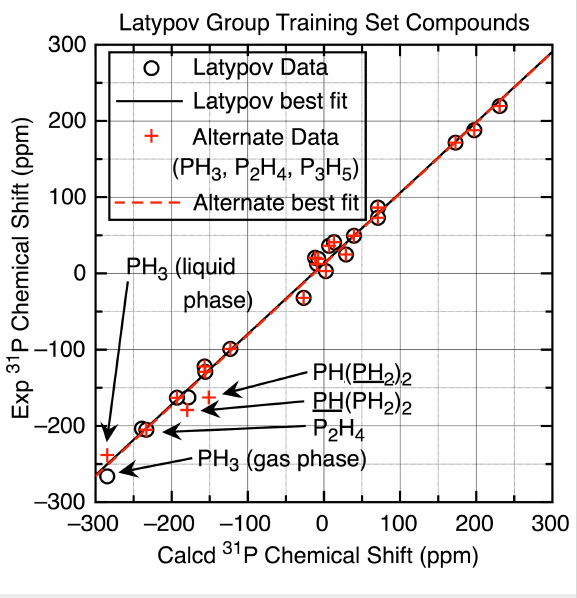
Figure 3: Plot of experimental vs calculated chemical shifts of training set compounds reported by Latypov et al. [37] (open circles, PBE0/6- 31+G(d) gas-phase optimization, PBE0/6-311G(2d,2p) gas phase NMR referenced to gas phase H 3 PO 4 ), and the best fit line to give scaling Equation 2 m = 0.925 ± 0.017, b = 13.2 ± 2.5, MAD/RMSD = 9.1/10.9 ppm. Alternate data includes PH 3 , (H 2 P) 2 (virtually un- changed), and both P atoms in (H 2 P) 2 PH instead (red + symbols) and best fit line to give scaling Equation 2 m = 0.926 ± 0.021, b = 11.9 ± 3.1, MAD/RMSD = 10.7/13.7 ppm.